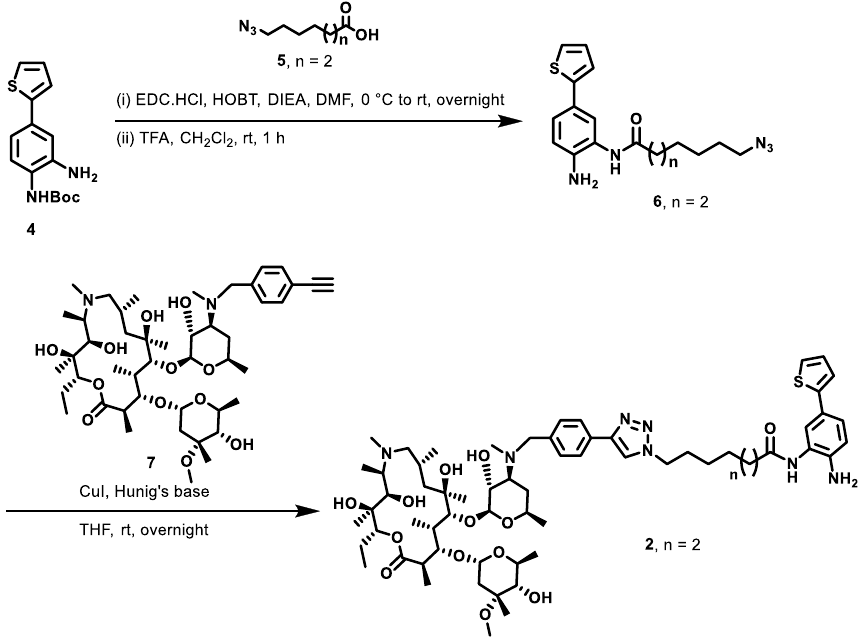
Scheme 1. Synthesis of compound 2 .